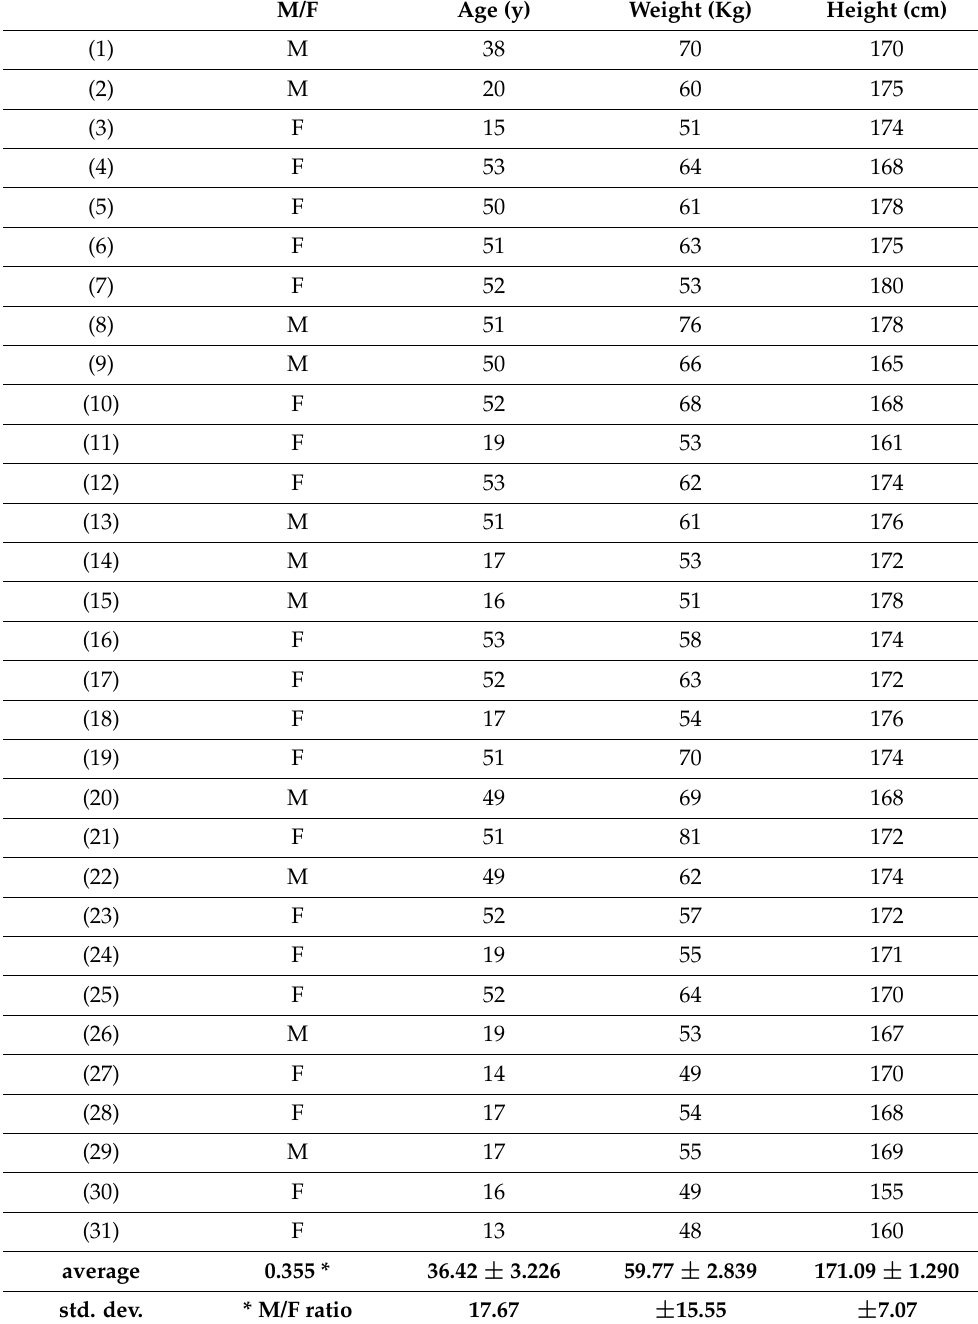
Table 1. Healthy volunteers’ data (sex, age, weight,